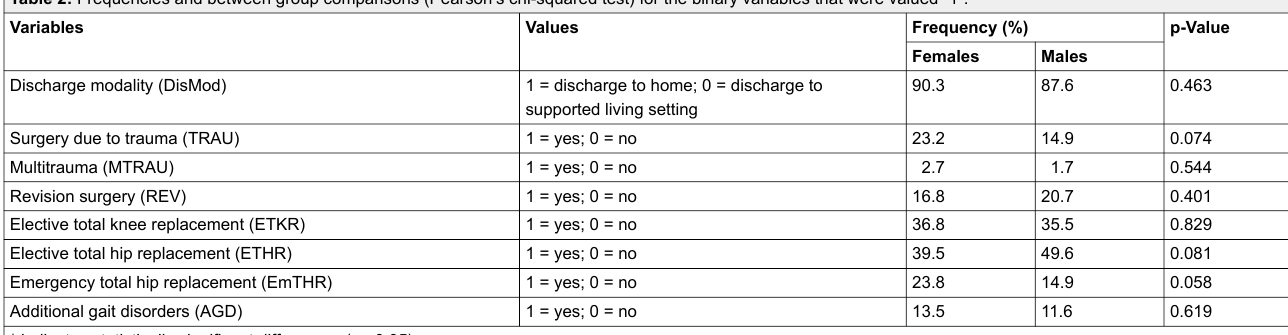
Table 2: Frequencies and between group comparisons (Pearson’s chi-squared test) for the binary variables that were valued